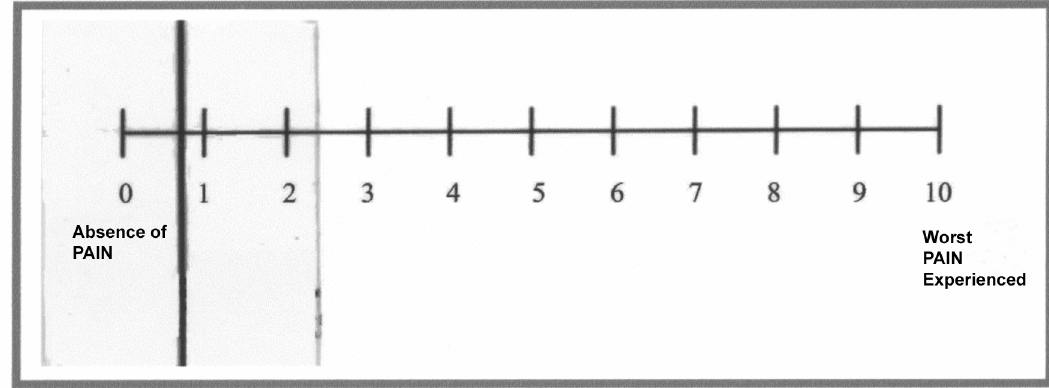
Figure 2 – Visual analogical scale for